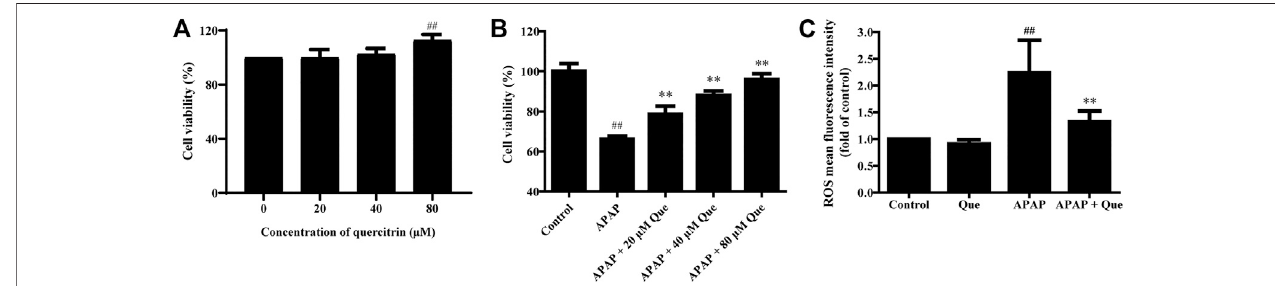
FIGURE5| EffectofquercitrinontheactivityandROSlevelsofAPAP-treatedL-02cells. (A) EffectofquercitrinontheviabilityofL-02cells. (B) Effectofquercitrinon the viability of APAP-treated L-02 cells. (C) Effect of quercitrin on ROS levels in L-02 cells. The experimental data are expressed as mean ± SD, and the experiment was